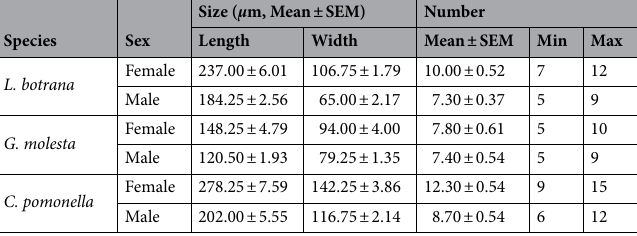
Table 1. Dimensions and number of sensilla chaetica on the apical segment of the labial palp.